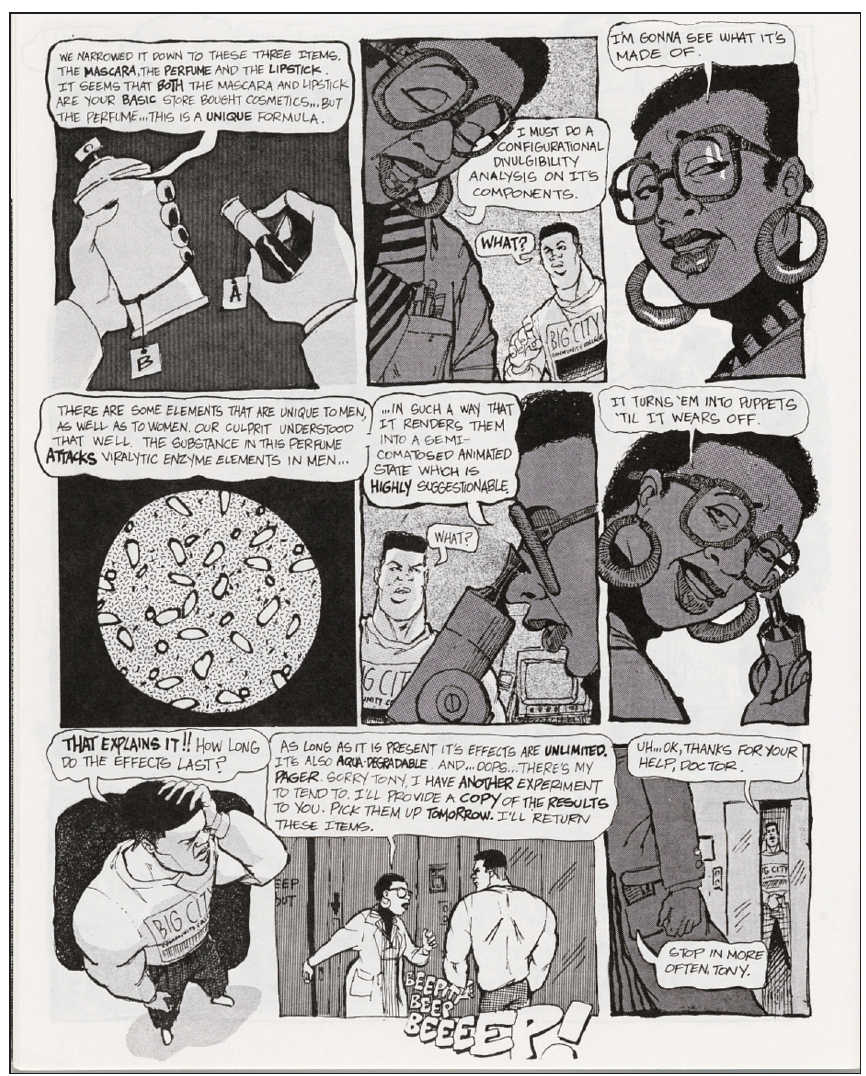
Figure 3: Excerpt from Sims J, Sims D, and Sims G (1990b) Brotherman: Dictator of Discipline #2 (East Orange, NJ) © Big City Entertainment,